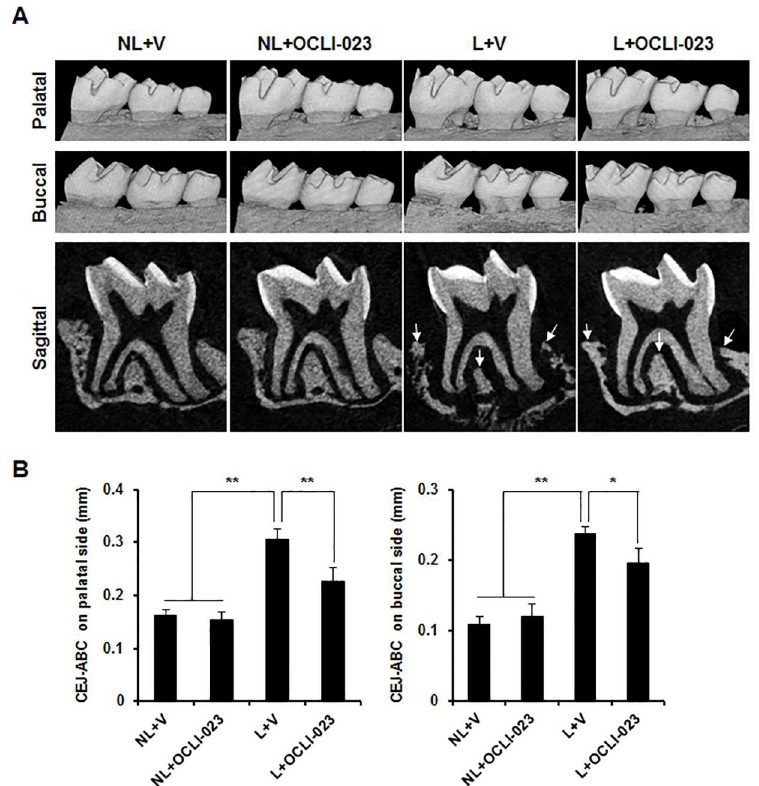
Fig 4. Micro-CT analysis of alveolar bones in mice with experimental periodontitis. (A) Both nonligated and ligated mice were injected with either vehicleor OCLI-023. Palatal (upper)and buccal (middle)sides of maxillaand sagittal (lower) sectionalmicroCT images of the second molar exhibitthe alveolarbone loss. NL + V, nonligatedwith the vehicle; NL + OCLI-023, nonligatedwith OCLI-023; L + V, ligated with the vehicle; L + OCLI-023, ligatedwith OCLI-023. (B) The linear distancefrom the CEJ to the ABC of the second molar was analyzed.n = 5 in each group. * p < 0.05, ** p < 0.01 versus the ligated, vehicle-treated